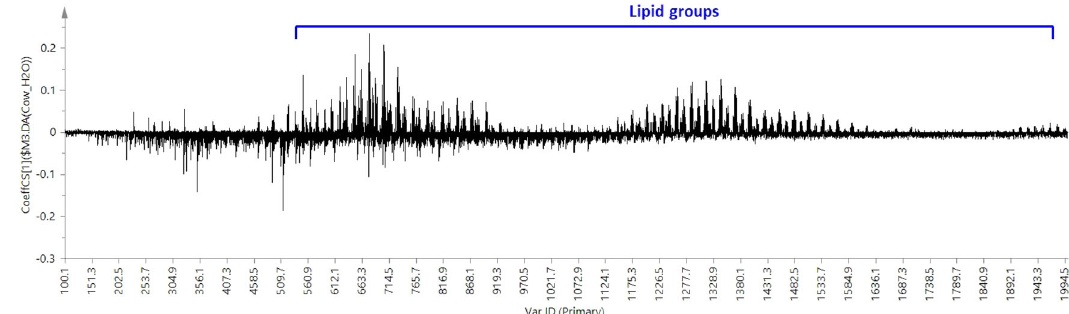
Fig. 1 The comparison of sample treatment differences. Coef fi cients for different sample treatment procedures, milk treated with methanol = − 1, milk treated with pure water =